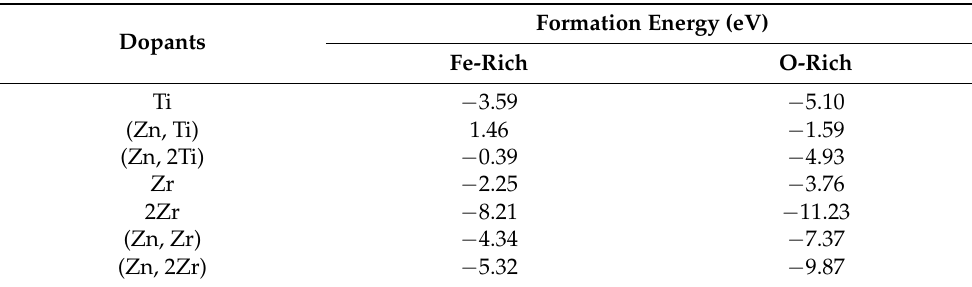
Table 1. E form of mono and bimetallic-doped {0001} hematite systems in O-rich (oxidising) and Fe-rich (reducing)